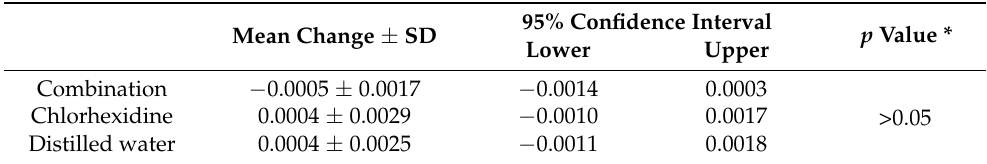
Table 3. GCF resting volume changes (resting volume after–resting volume before) after rinsing with different study